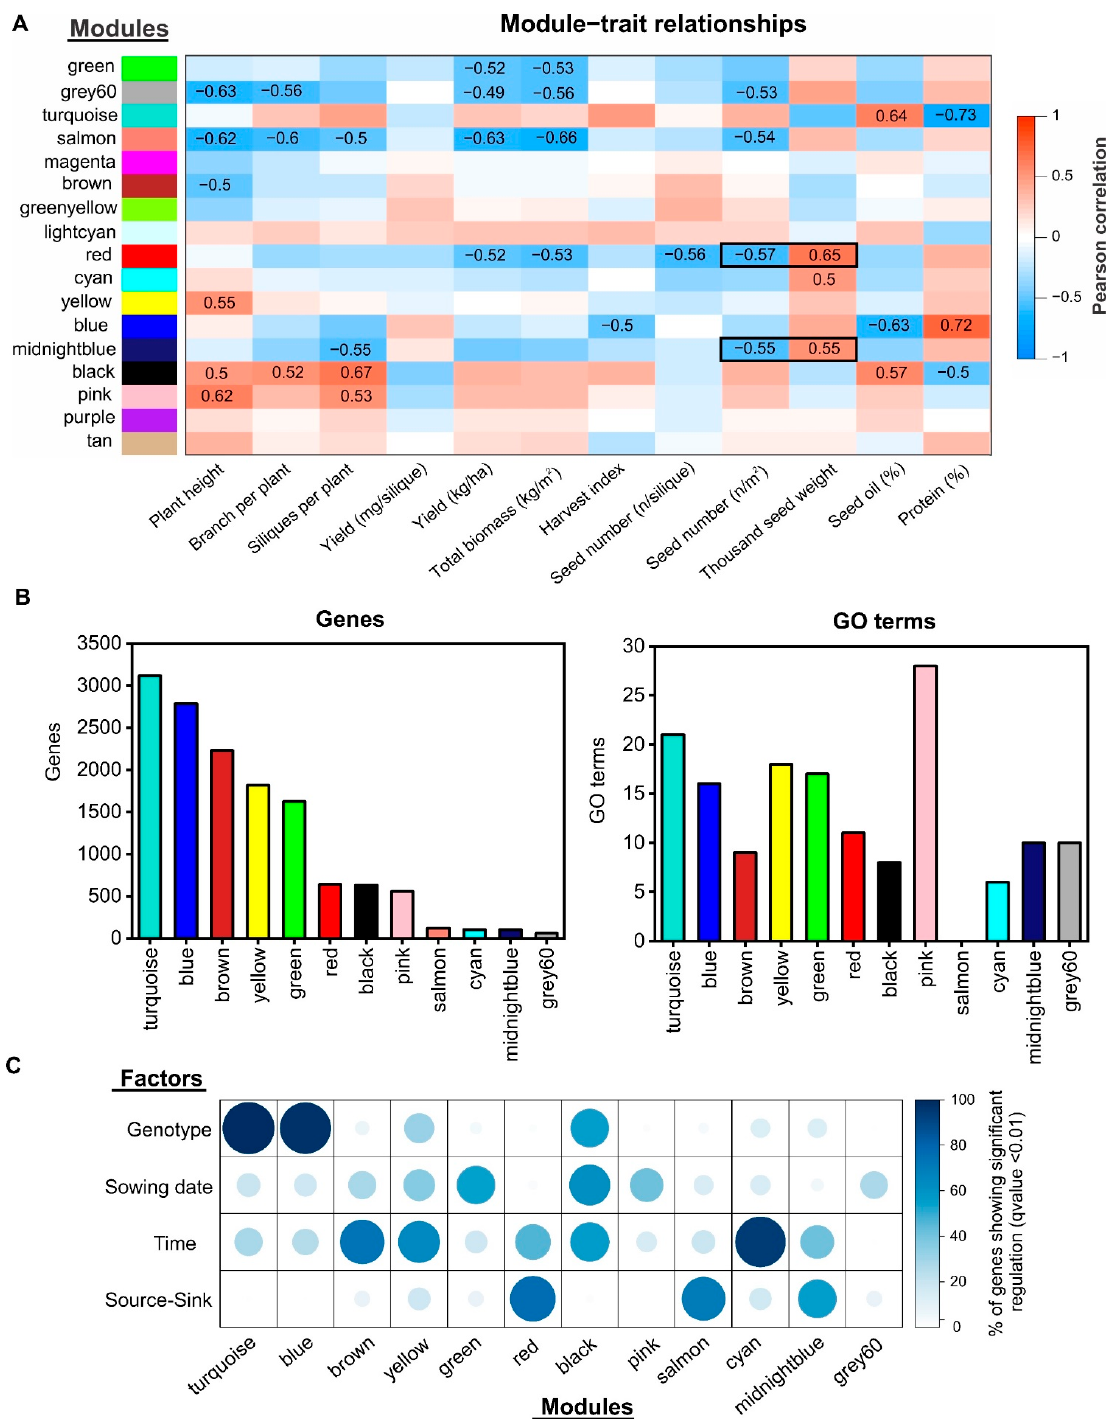
Figure 5. Weighted gene co-expression network analysis identified the modules associated with the SW and SN relationship at 14 DAF. ( A ) A heatmap showing the module–trait associations. Each row corresponds to a module eigengene, and each column corresponds to a trait. Only significant correlations ( p -value < 0.01) are shown with numbers. Red and blue denote positive and negative correlations with gene expression, respectively. The agronomics traits were obtained from our previous work [16]. The modules significantly correlated with SW and SN are indicated with a black rectangle. ( B ) Histograms showing the number of genes (left) and GO terms (right) per co-expression module. Only modules significantly correlated with at least one agronomic trait are represented. ( C ) Balloon plot showing the percentage of genes in each module that are significantly regulated by each